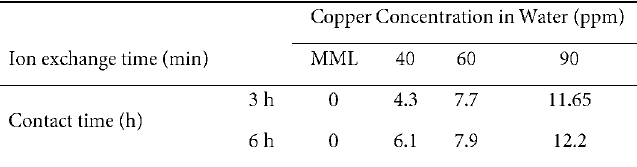
Table 1. Copper concentration in water at different contact times between CuO/SGn and the aqueous